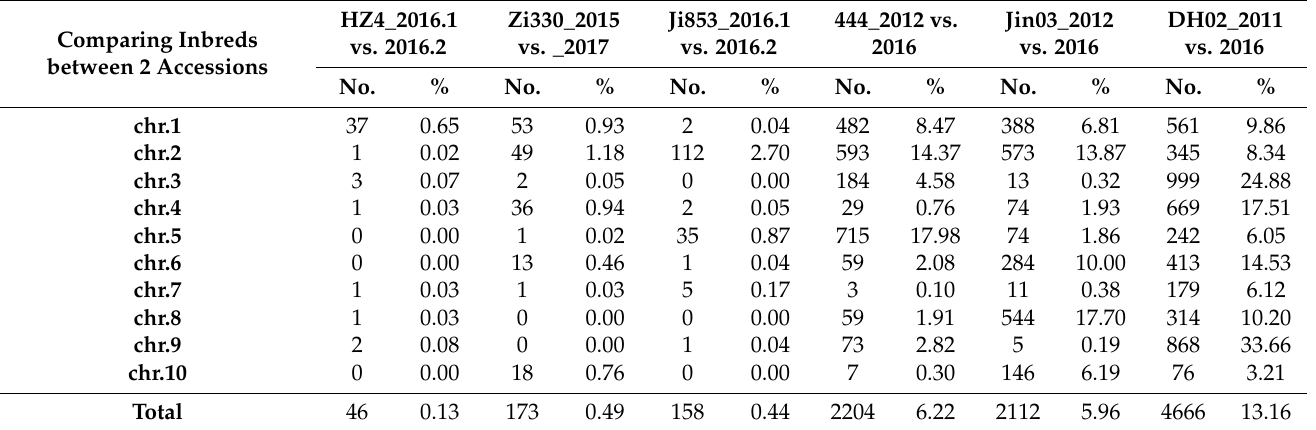
Table 2. Evaluation of the genetic drift between two accessions of inbreds using genome-wide SNP genotypes.